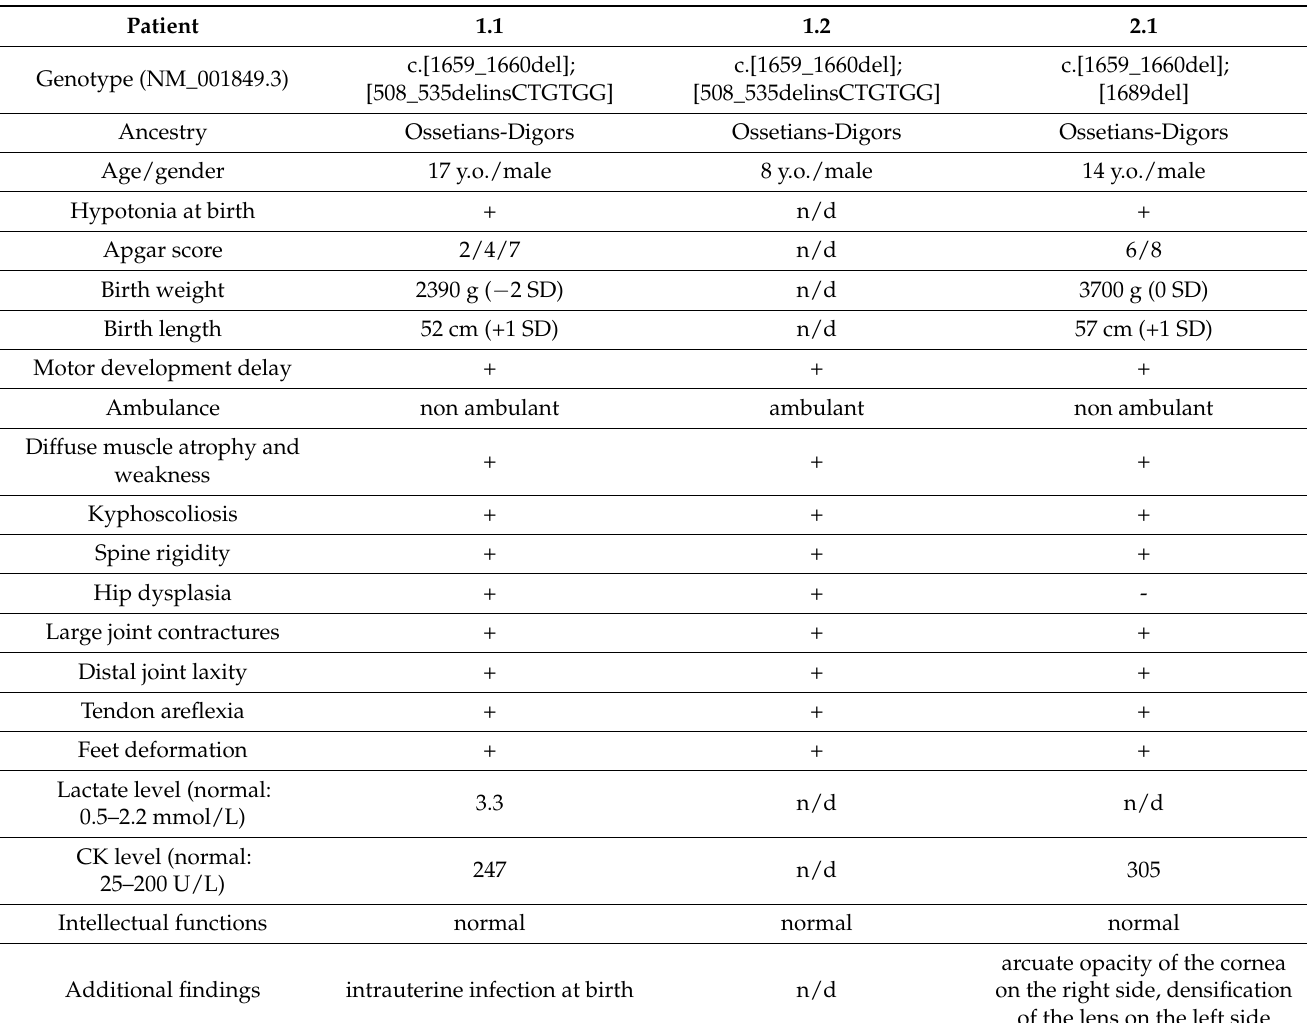
Table 1. Comparison table with clinical